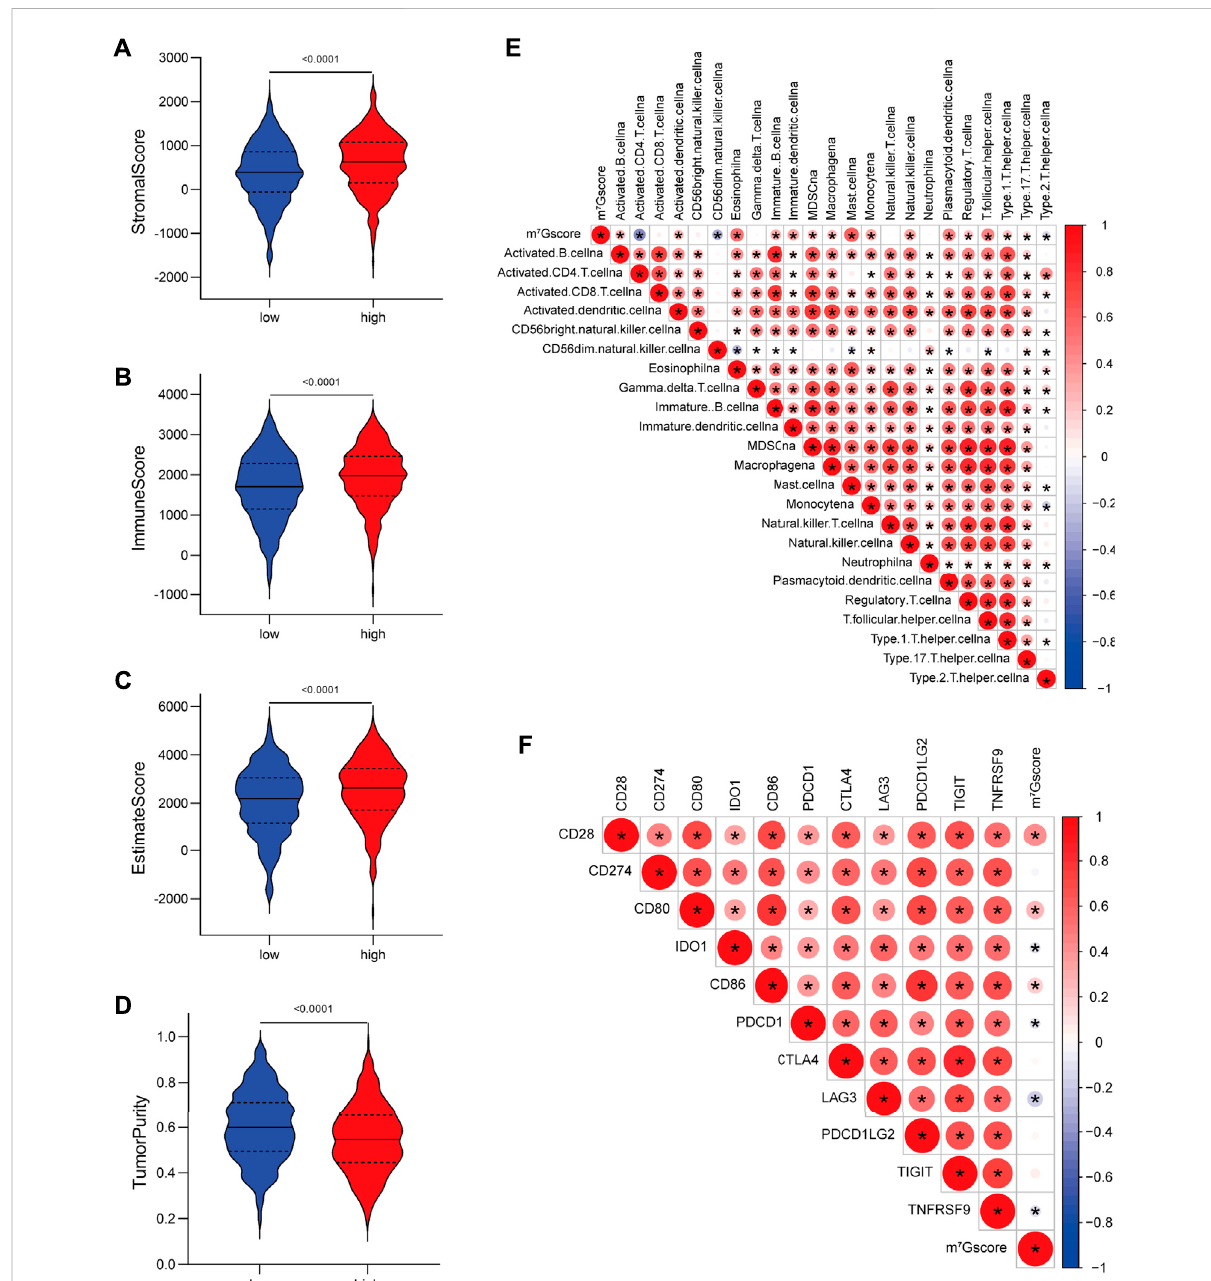
FIGURE 6 Correlations between m 7 G signature and the tumor microenvironment characteristics. (A – D) Violin plots show differences in the (A) immune score, (B) stromal score, (C) estimate score and (D) tumor purity between low and high m 7 Gscore groups. (E) Correlations between m 7 Gscore and theabundanceof23TMEin fi ltratingcells. (F) Correlationsbetweenm 7 Gscoreandimmune-checkpointrelatedgeneexpression.Positivecorrelation was marked with red and negative correlation with blue. The circle color represents Spearman coef fi cient value, the size of circle is inversely proportional to the p -value, and the asterisk stands for p <